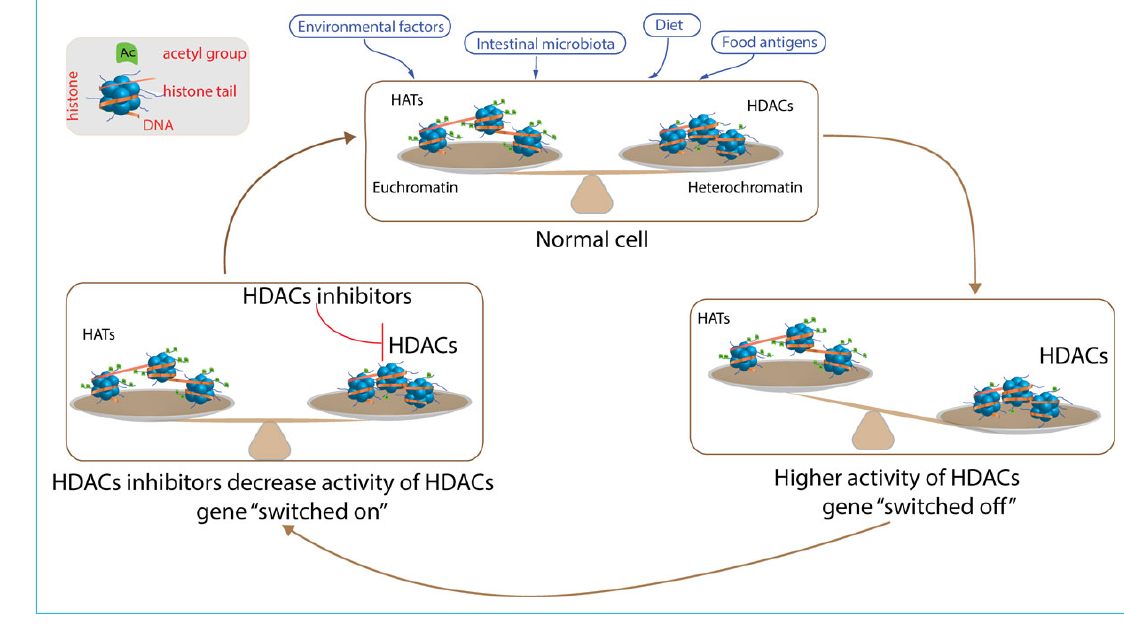
Figure 1: Epigenetic regulation of gene expression – histone acetylation. Cells in the gastrointestinal track are exposed to several envi- ronmental factors, dietary antigens, intestinal microbiota and microbiota derived-metabolites that may modulate epigenetic machinery. In the steady state, there is a balance between acetylation and deacetylation. Increased activity of histone deacetylases (HDACs) leads to higher hi- stone deacetylation, which causes formation of heterochromatin and silences gene expression. On the other hand, treatment with HDAC in- hibitors decreases HDAC activity and restores balance between acetylation and deacetylation in the cell, allowing genes to be transcribed. HAT = histone